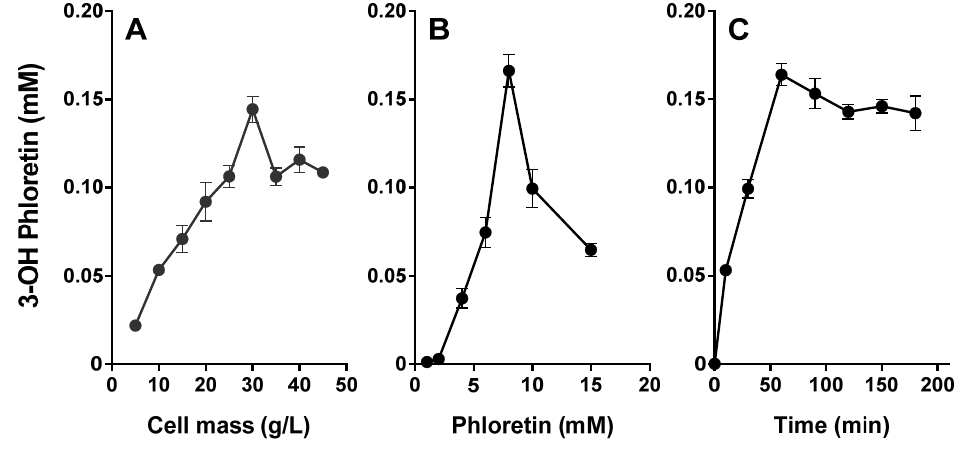
Figure 7. Whole-cell biotransformation of phloretin by a recombinant E. coli cell expressing CYP3A4. ( A ) E ff ect of cell concentration on the conversion of phloretin into 3-OH phloretin by whole cells expressing CYP3A4. The reactions were performed with cell concentrations from 5 to 45 g L − 1 and 10 mM of phloretin at 37 ◦ C for 60 min. ( B ) The e ff ect of phloretin concentration on the production of 3-OH phloretin by recombinant whole cells expressing CYP3A4. The reactions were performed in a range from 1 to 15 mM with 30 g L − 1 cells at 37 ◦ C for 60 min. ( C ) Time courses of phloretin into 3-OH phloretin by recombinant E. coli cells expressing CYP3A4. The reactions were performed with 30 g L − 1 cells and 8 mM of phloretin at 37 ◦ C for 180 min. Data are shown as the means ± the SD of triplicate determinations.